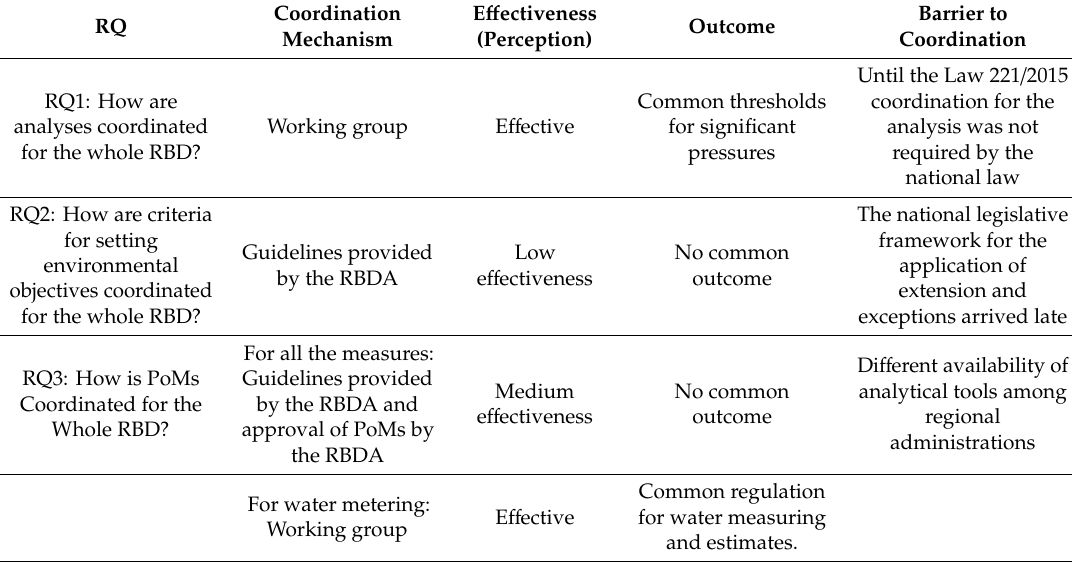
Table 2. Summary of the results related to the research questions 1, 2 and 3 presented in Figure 1.